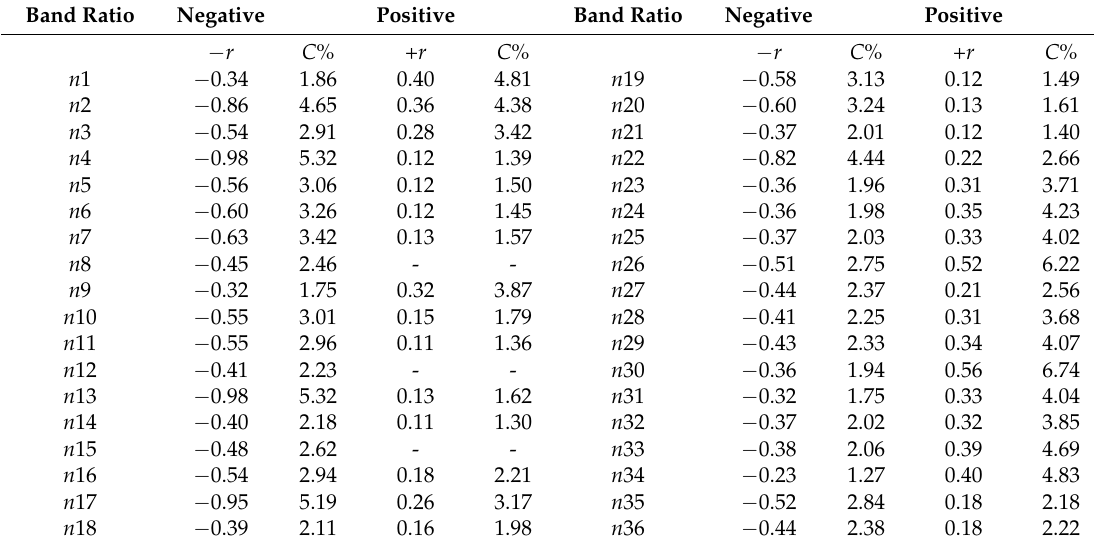
Table 2. Positive and negative correlation ( ± r) and contribution percent (C%) of the band ratios n1–n36 used for Band Ratio Matrix Transformation (BRMT).